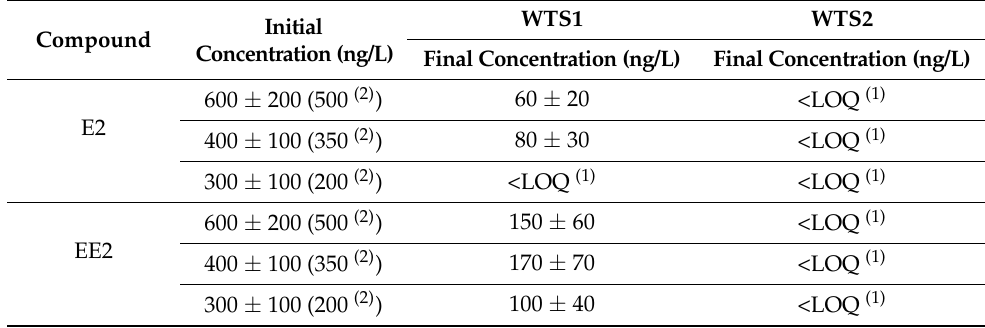
Table 3. Final concentrations of the emerging pollutants in the two water treatment sludges (WTSs) evaluated.